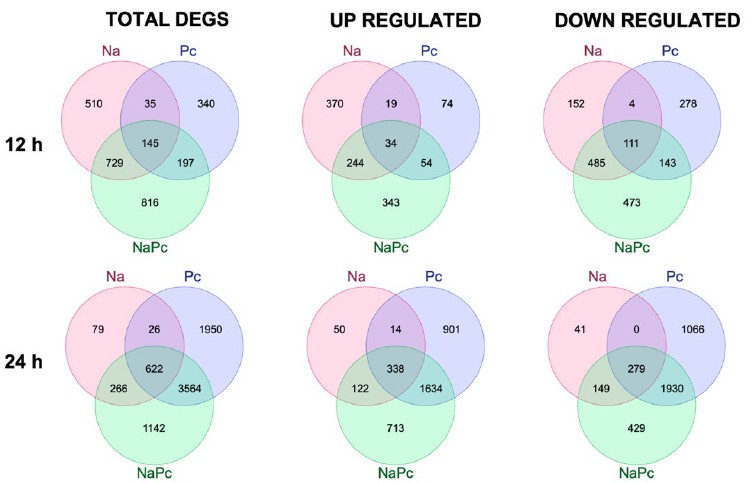
Figure 1. Venn diagrams display the overlapping of differential expressed genes (DEGs) identified at 12 and 24 h with each treatment. Na: Nacobbus aberrans treatment. Pc: Phytophthora capsici treatment. NaPc: Phytophthora capsici treatment after Nacobbus aberrans treatment. Numbers represent the total genes for each group.